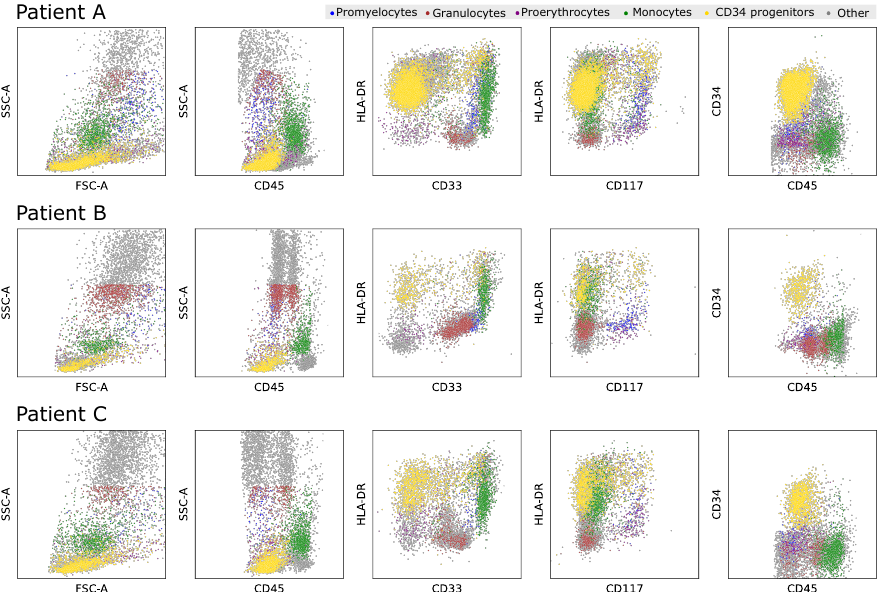
Figure A1. Healthy cell populations exhibit low variation between patients. Each row shows an FCM sample of a blast-free patient taken at the same stage during therapy (after the third cycle of consolidation therapy). Differences in density as well as minor shifts of locations are noticeable. Colors of events falling into the bermude area represent promyelocytes (blue), granulocytes (brown), proerythrocytes (purple), monocytes (green), CD34 progenitors